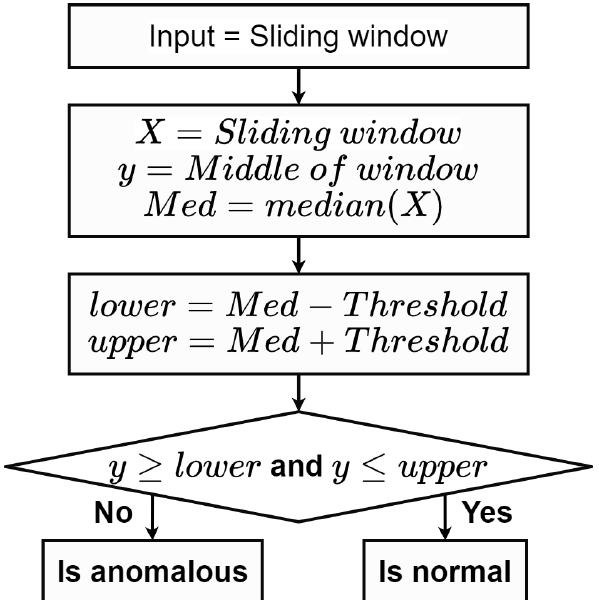
Figure 2. A flow chart of the median with fixed threshold